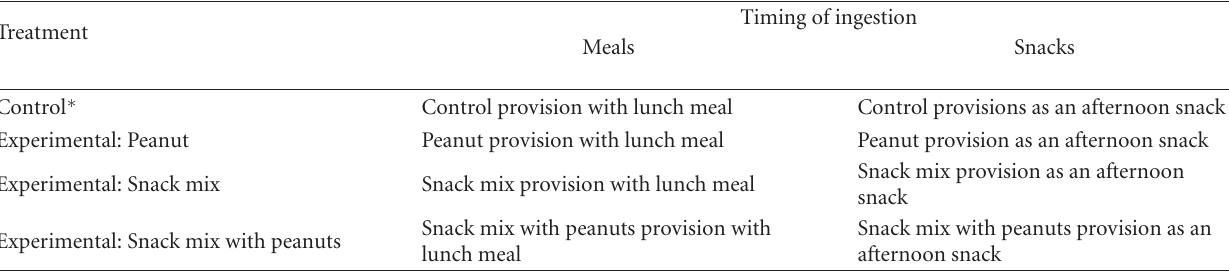
Table 1: Study treatment session presented to participants.